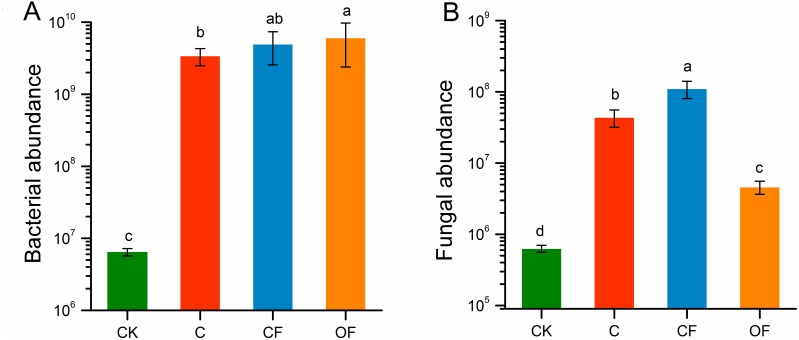
The absolute abundance of bacteria and fungi in the four soils studied.Different letters indicate significant differences based on LSD test at p < 0.05. Error bars represent one standard error of the mean (n = 6).